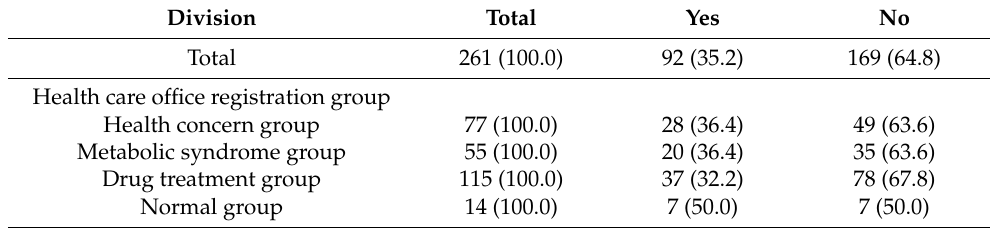
Table 2. Visits to the dental office at the public health center or the local community dental